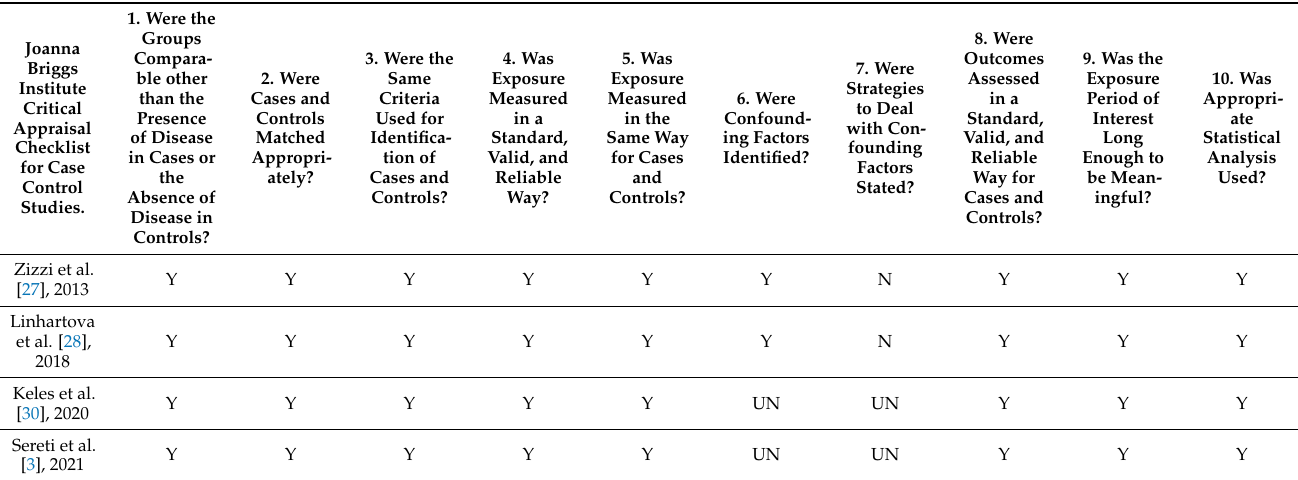
Table 2. Joanna Briggs Institute Critical Appraisal Checklist for Case Control